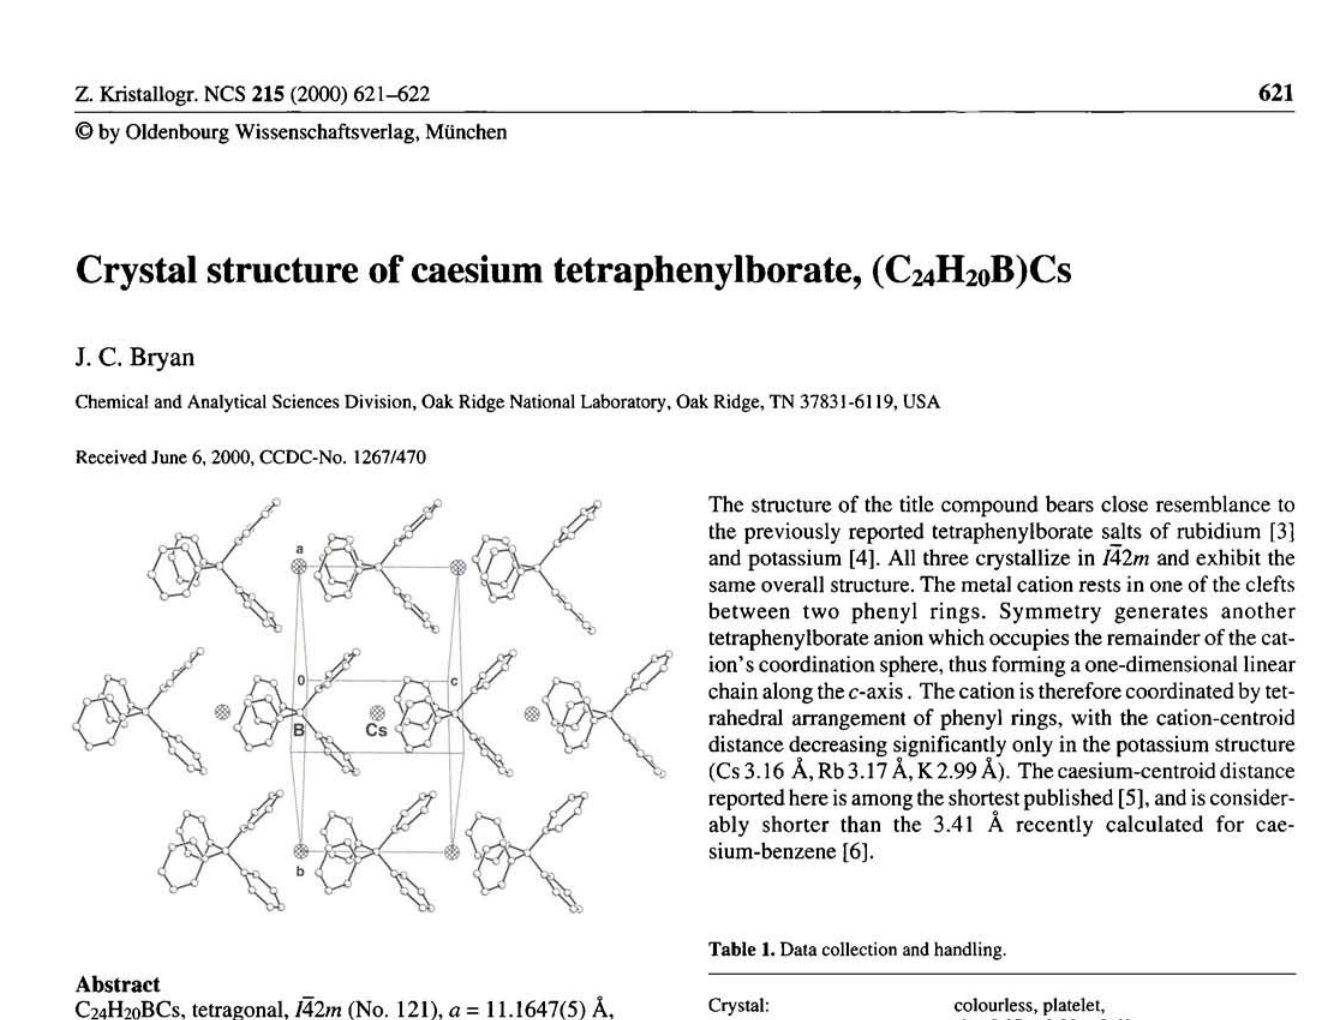
Table 2. Atomic coordinates and displacement parameters (in Â 2